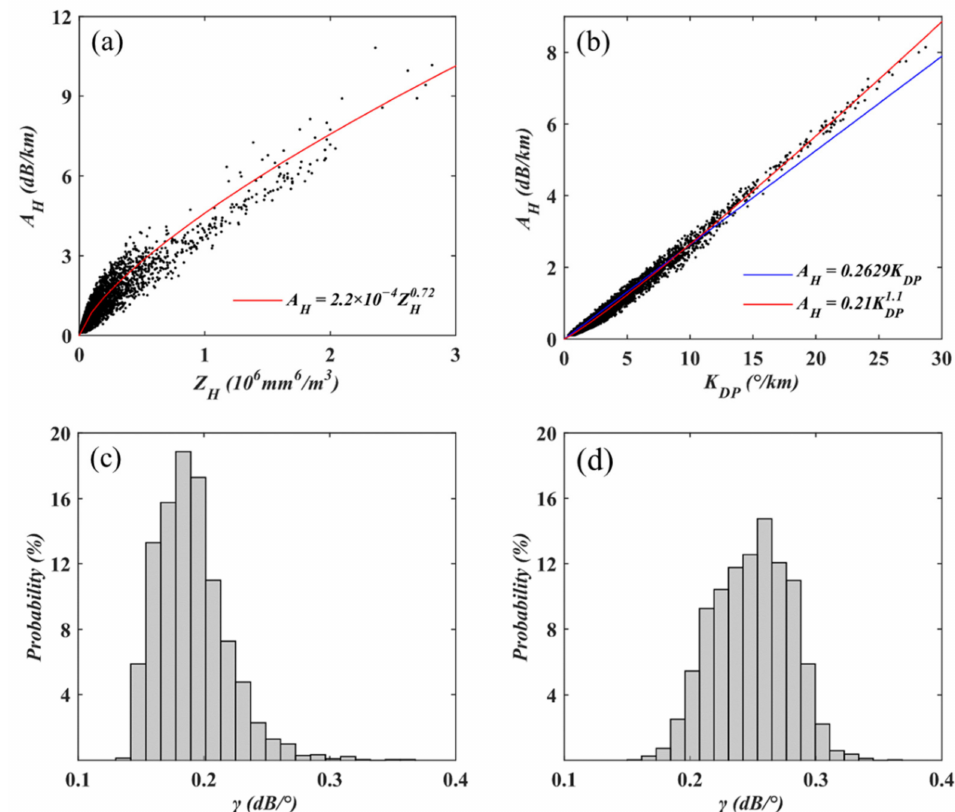
Figure 4. Exponential-fitting results of Z H and A H ( a ); linear relationship (blue line) and exponential relationship (red line) between K DP and A H ( b ); probability distribution of the γ value calculated according to the linear relationship for Z H < 45 dBZ ( c ) and for Z H > 45 dBZ ( d ).